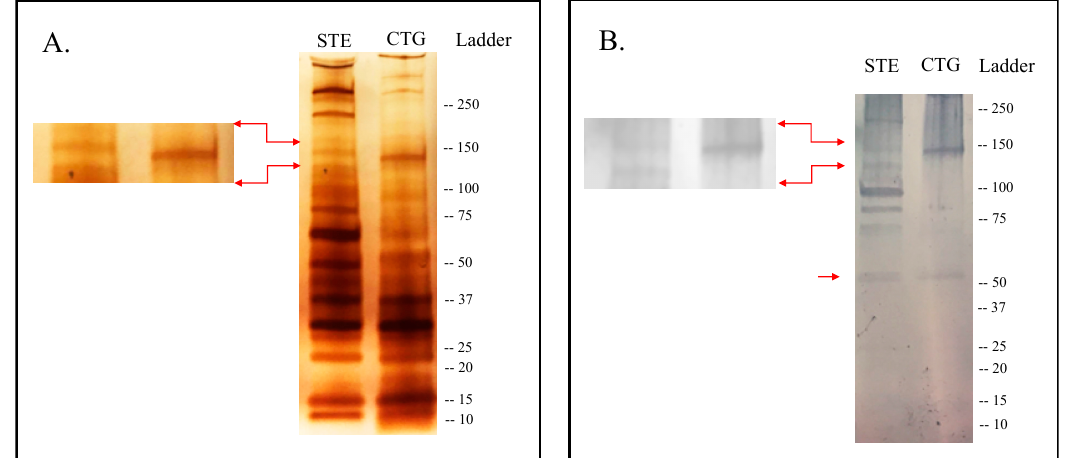
Figure 1. Band profile of salivary proteins contained in whole salivary gland extract (SGE) of An. albimanus strains STECLA (STE) and Cartagena (CTG). ( A ) Silver stain of proteins highlighting the ~140 kDa band absent in STE. ( B ) Immunoblotting with serum samples from healthy volunteers living in a malaria endemic area, highlighting the high reactivity against the ~140 kDa band in the CTG strain as well as the reactivity to a ~65 kDa band in both strains.